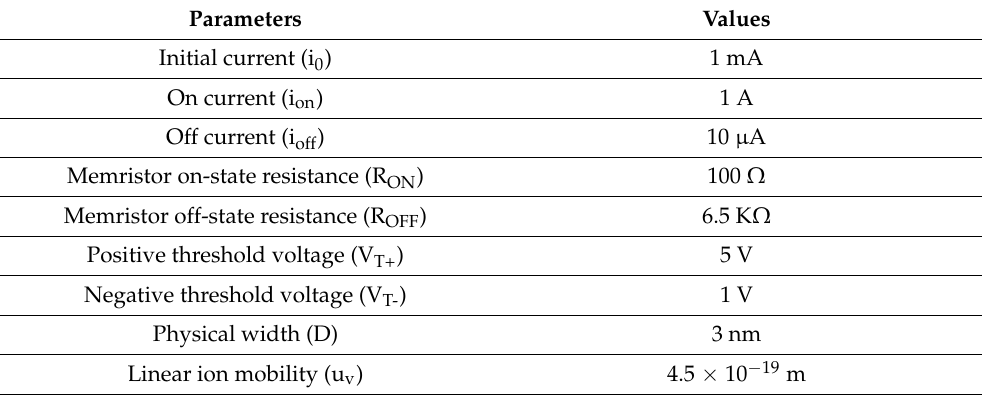
Table 1. The key parameters of the modeled